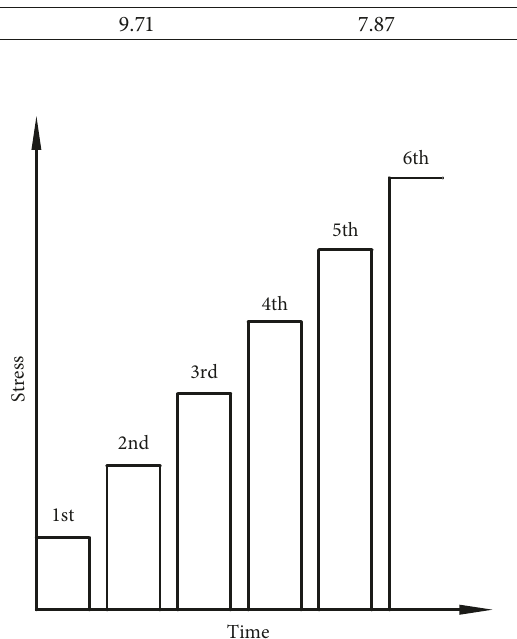
Figure 3: Multilevel loading-unloading process for uniaxial creep